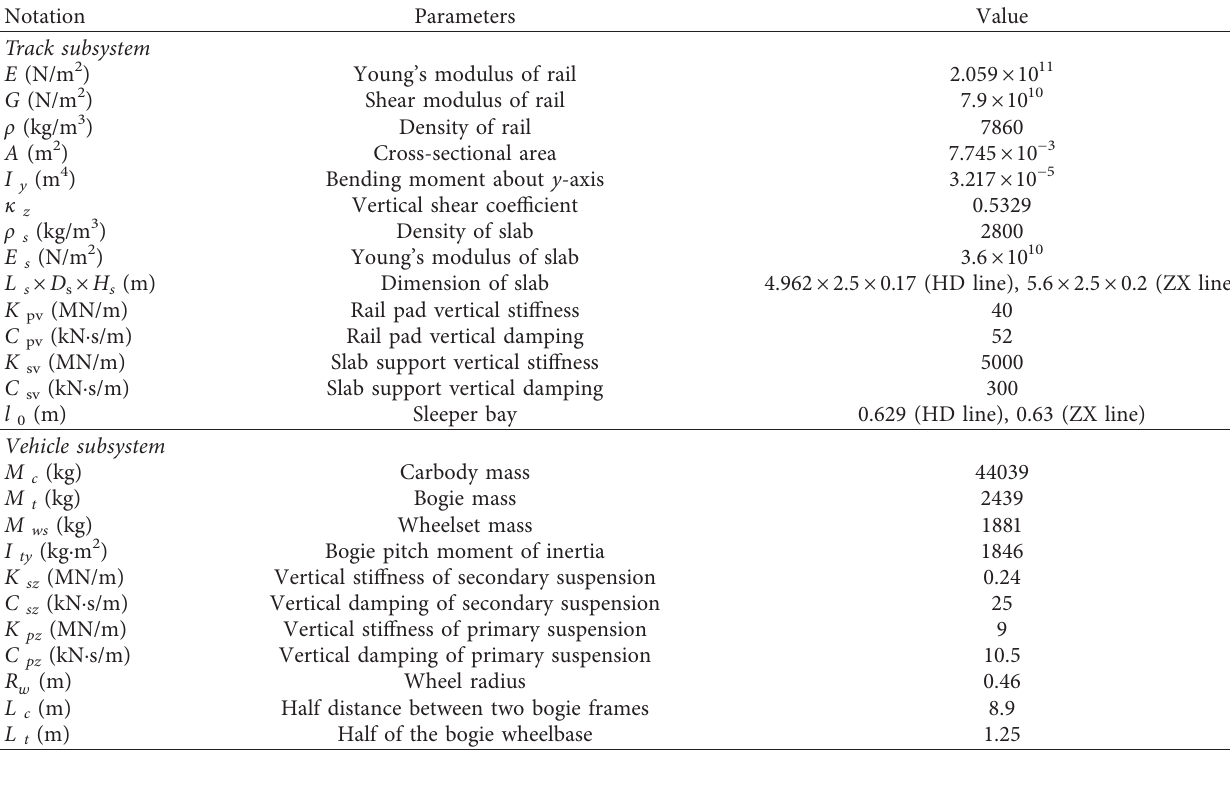
Table 2: Value of